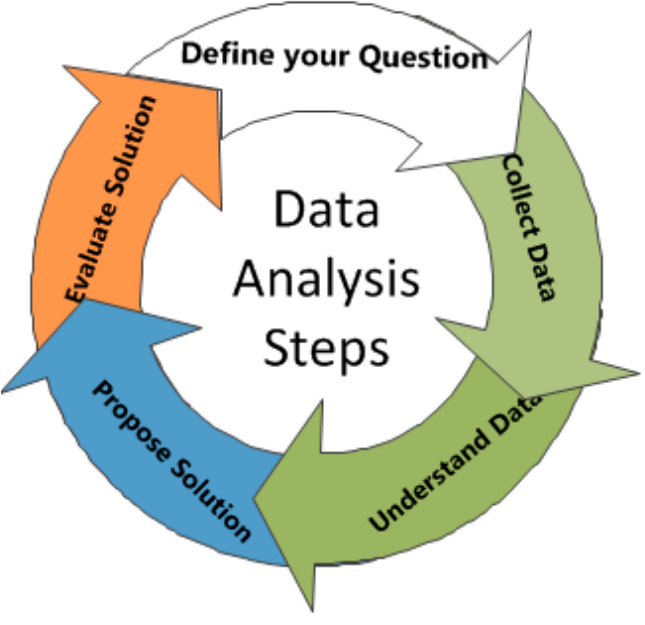
( b ) Figure 2. The Houston Advanced Research Center Building: ( a ) outside view, ( b ) photovoltaics arra y . The power consumption data were collected at different building levels and included